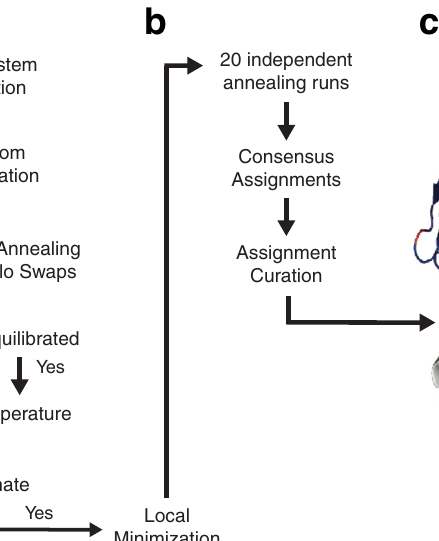
swapping of individual crosspeaks or entire spin systems is outlined in Fig. 2. Annealingcontinuesuntilenergyequilibrationisachieved.Thetemperatureisthen loweredandthesystemre-equilibrated.Annealingisstoppedwhenthetermination criteria are met and a local minimization routine is performed. b The fi nal reso- nance assignments are developed from results of multiple independent simulated annealingruns. c Shownisaribbonrepresentationofmaltosebindingprotein(PDB code: 1DMB [https://doi.org/10.2210/pdb1DMB/pdb]) color-coded according to assignmentstatusfollowinganalysisbyBARASA:correctlyassignedresidues(blue); unassigned residues (white), prolines (red). See main text for further